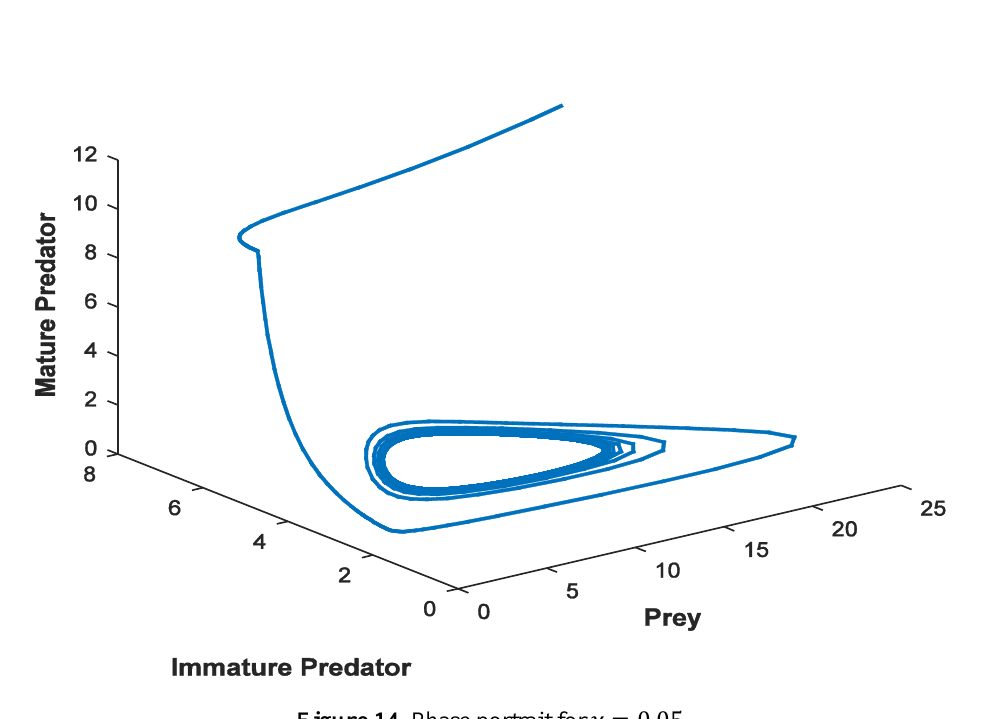
Figure 14. Phase portrait for 𝛾 =